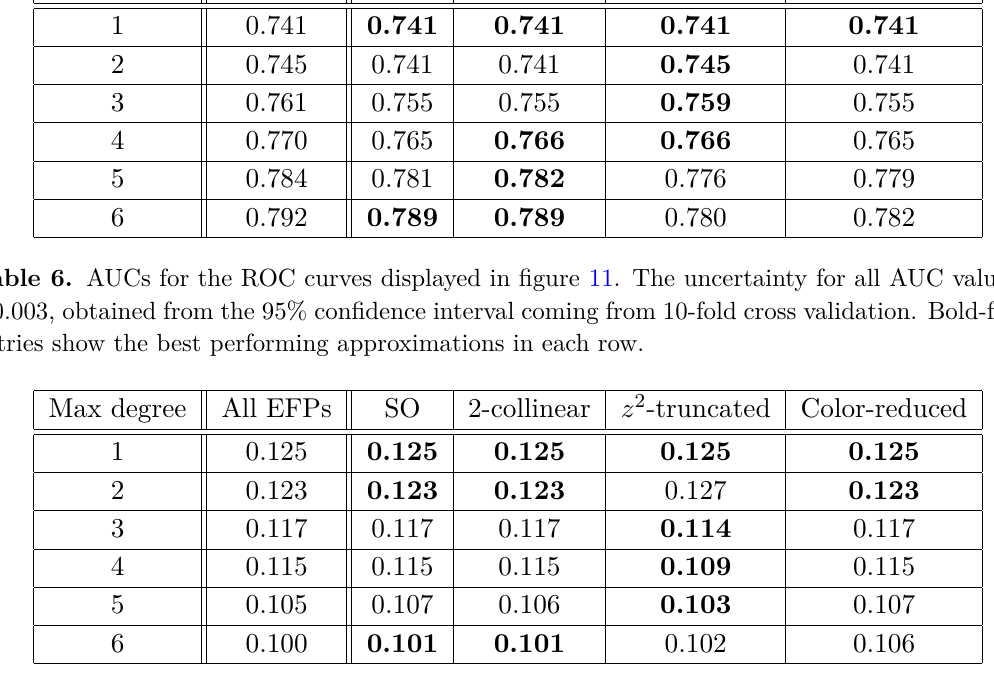
Table 7. Gluon mistag rate at 0.5 quark efficiency. The uncertainty for all values is ± 0.004, obtained from the 95% confidence interval coming from 10-fold cross validation. Bold-faced entries show the best performing approximations in each